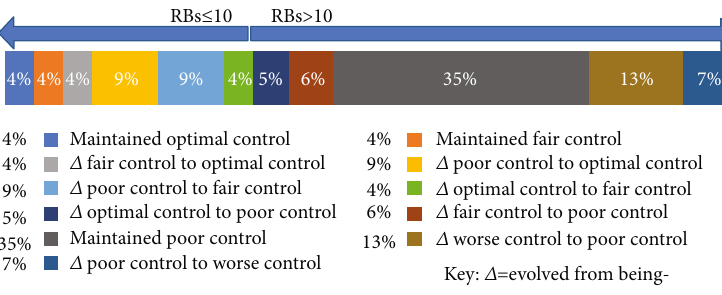
Figure 1: Description of aggregated patients diabetes control over 3 years. Change in RBS control over 3